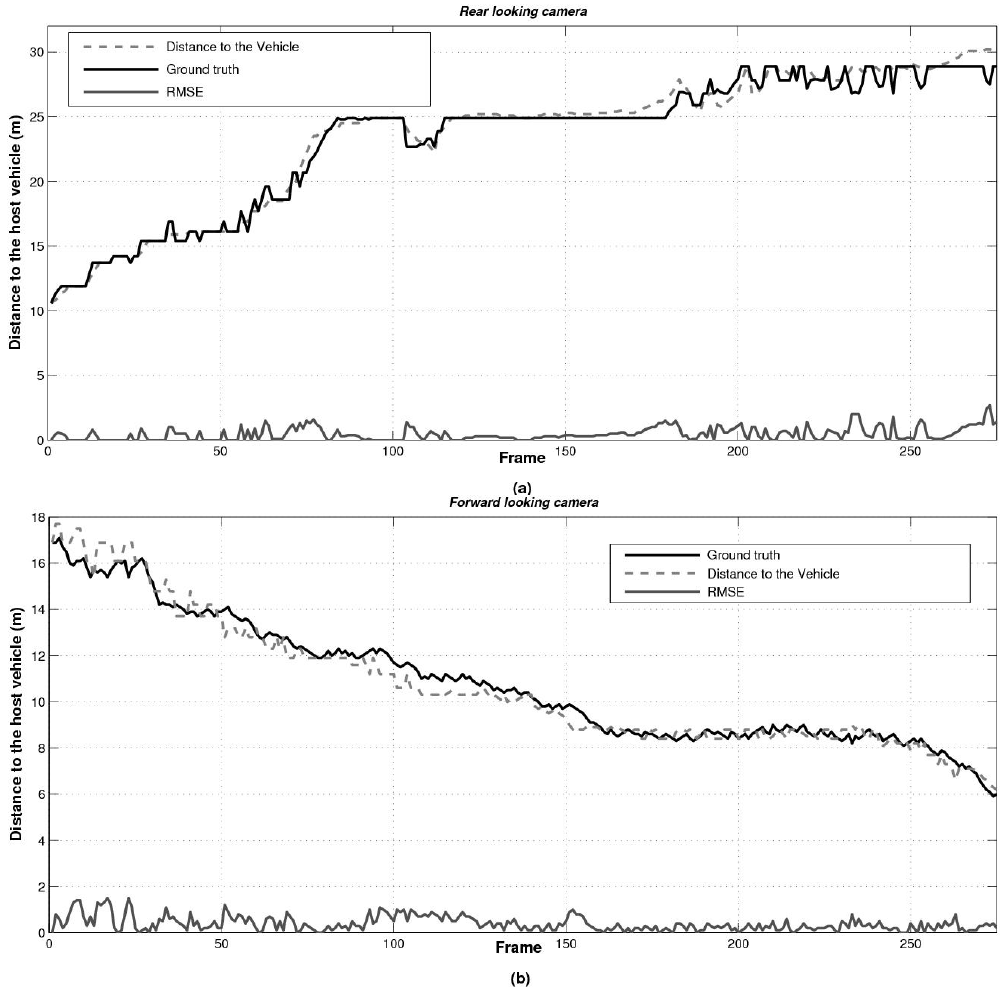
Figure 16. Estimated host-to-vehicle distance by the proposed sensor, ground truth and absolute error in two examples corresponding to (a) rear and (b) forward vision modules.